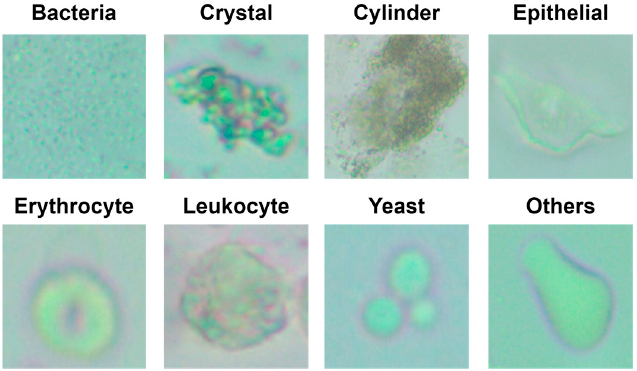
Figure 1. Example images of classes in the data set.